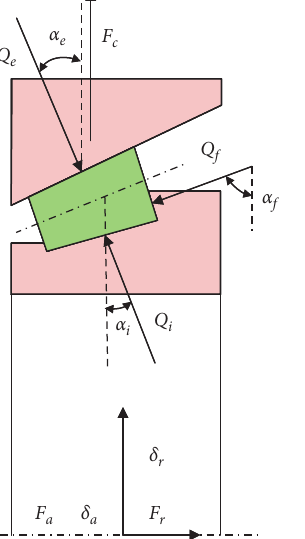
Figure 5: Schematic diagram of bearing